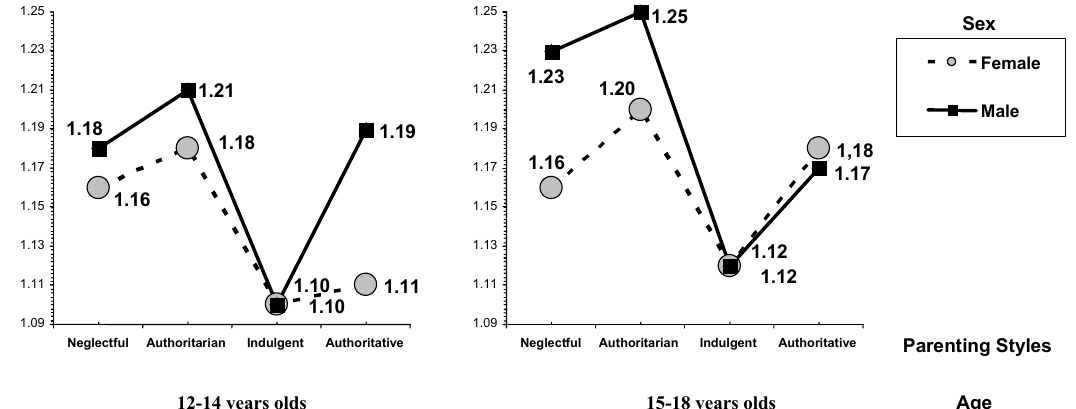
Figure 1. Means of proactive violence by parenting style, sex, and age.